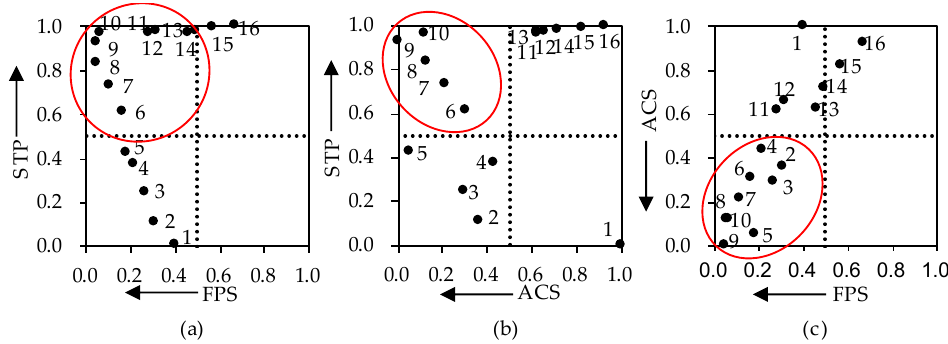
Figure 5. Paired analysis and relationships between STP and FPS ( a ), STP and ACS ( b ), and FPS and ACS ( c ). The MRs located in the red circle region are BMRs.